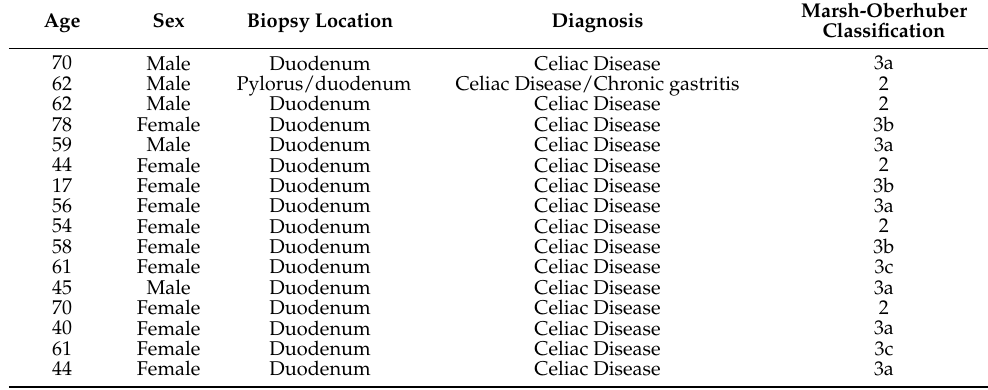
Table A1. Clinicopatholgical